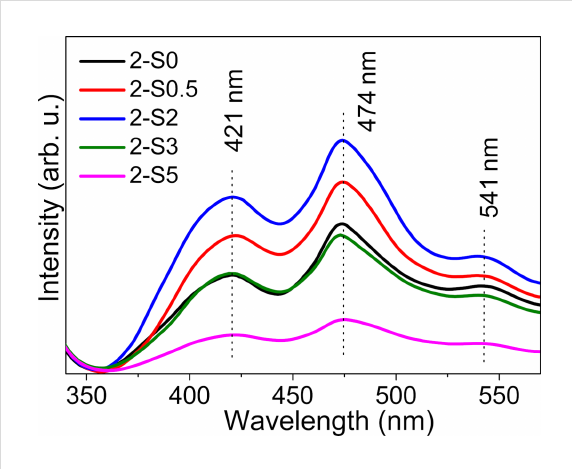
Figure 9: The PL spectra of 2-S0, 2-S0.5, 2-S2, 2-S3 and 2-S5 using an excitation wavelength of λ ex = 300 nm.